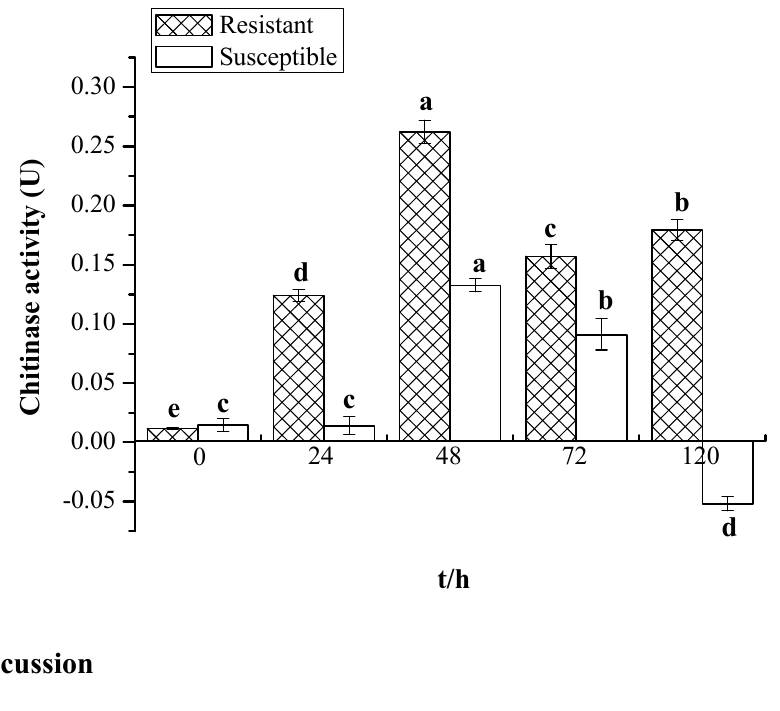
Figure 1. The chitinase activity in smut-resistant (Yacheng05-179) and smut-susceptible (Liucheng03-182) sugarcane cultivars inoculated with Sporisorium scitamineum . All data points (with the deduction of their mocks) are the means ± SE ( n = 3). Different lowercase letters indicate a significant difference, as determined by the least-significant difference test ( p -value < 0.05). U, unit of chitinase